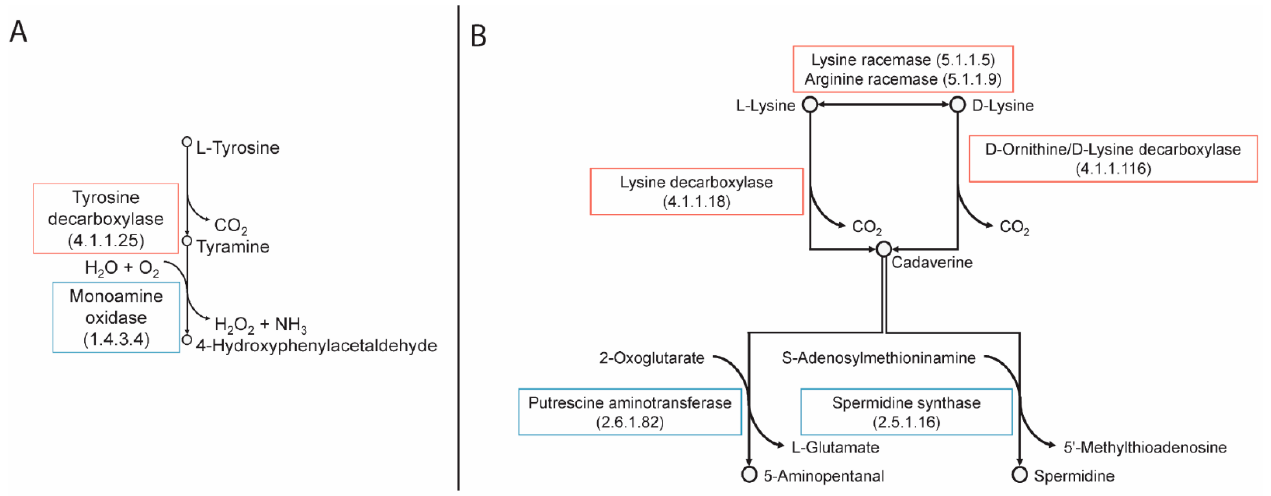
Figure 3. Metabolic pathways for the synthesis and degradation of tyramine ( A ) and cadaverine ( B ).